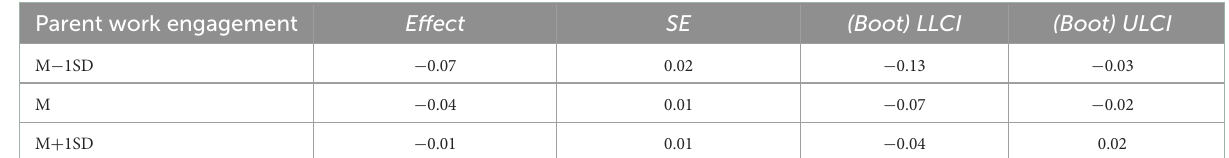
TABLE 5 Summary of moderated mediation